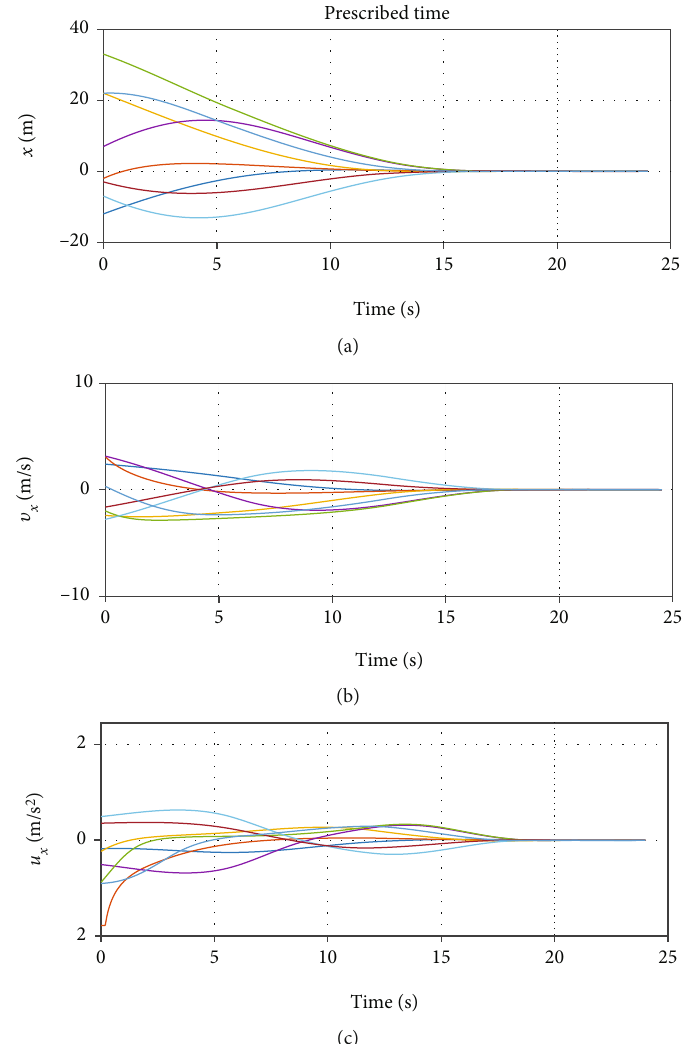
Figure 7: The x -axis (a) position error, (b) velocity error, and (c) control input curves of the proposed controller with the prescribed time = 20s t f